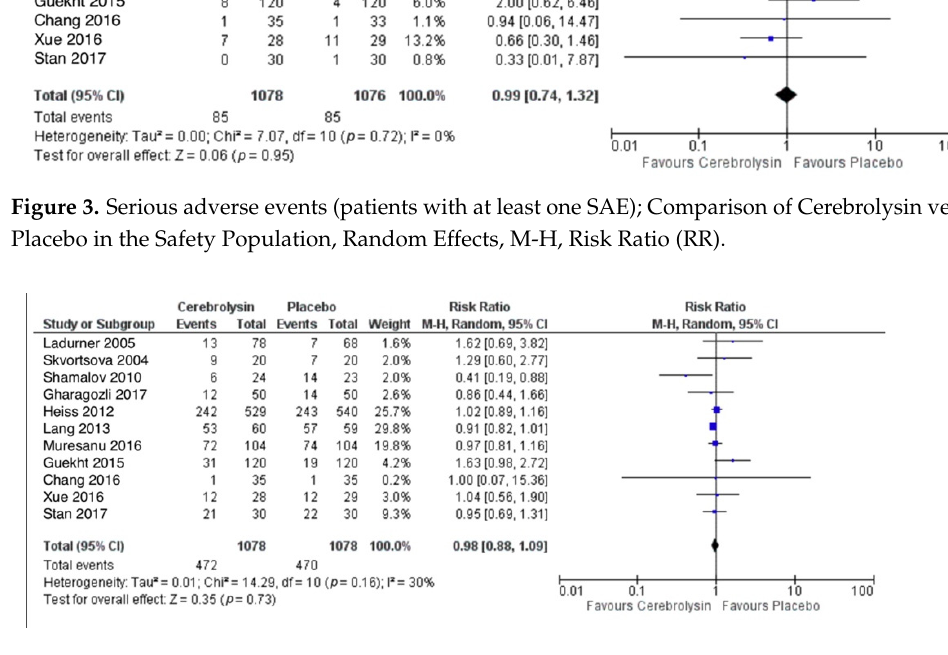
Figure 3. Serious adverse events (patients with at least one SAE); Comparison of Cerebrolysin ver- sus Placebo in the Safety Population, Random Effects, M-H, Risk Ratio (RR).